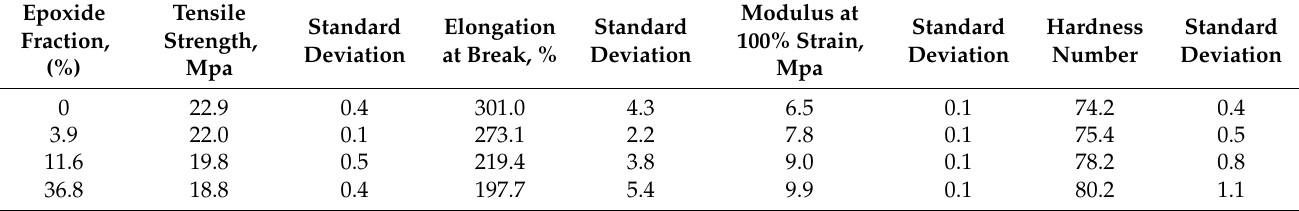
Table 5. Tensile strength, elongation at break, modulus at 100% strain and hardness number of